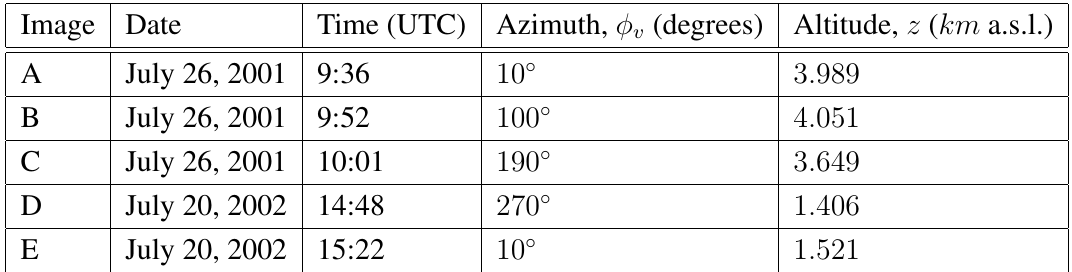
Table 2 . The ancillary data for each MIVIS